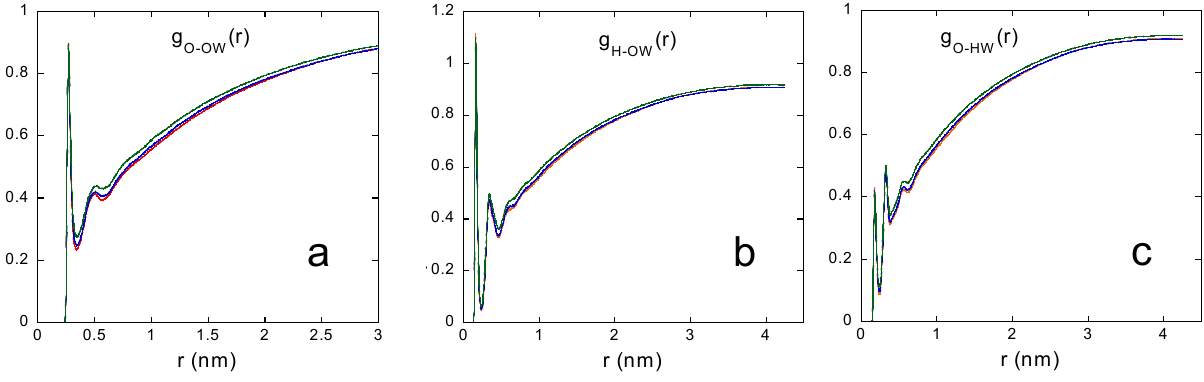
Figure 4. Radial distribution function between PVA and water atoms. Red, blue and green curves refer to 283, 293 and 313 K, respectively. Average over the last ns